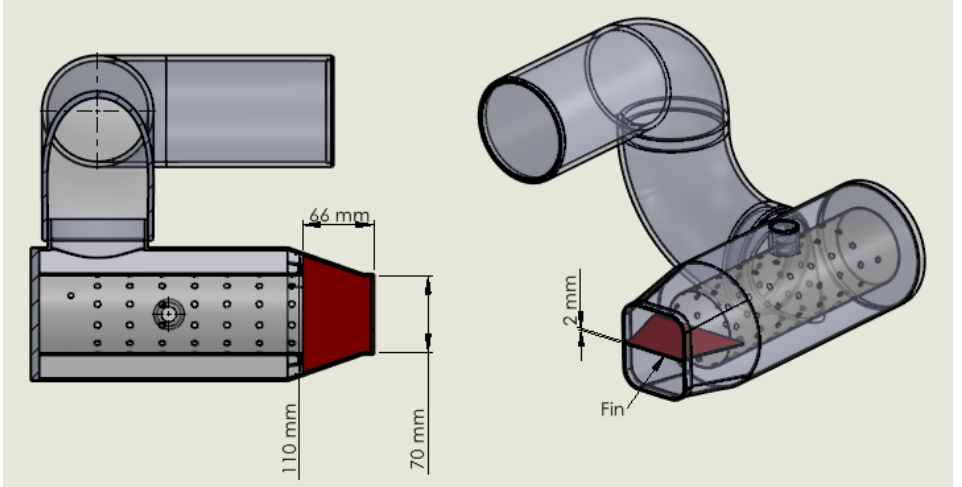
Figure 10. Dimensions of the fin added to the turbine intake.